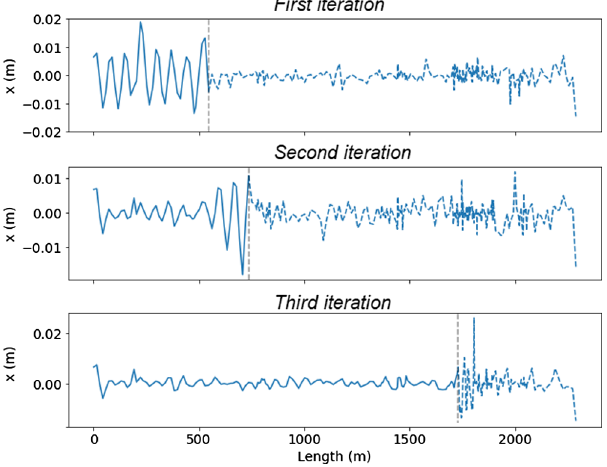
FIG. 7. Several iterations of beam threading with a